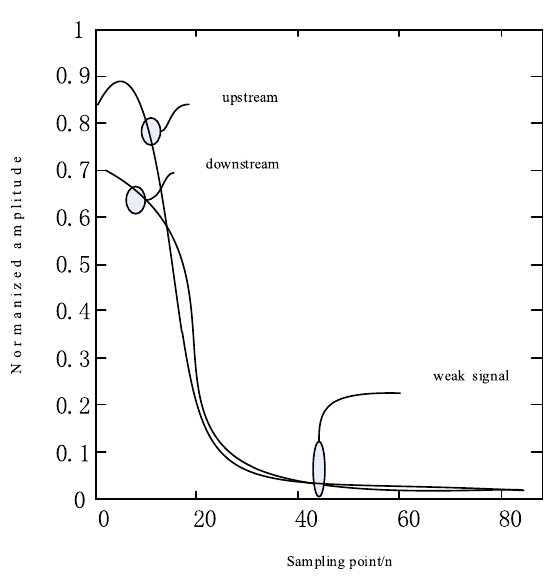
Fig. 3 transient attenuation